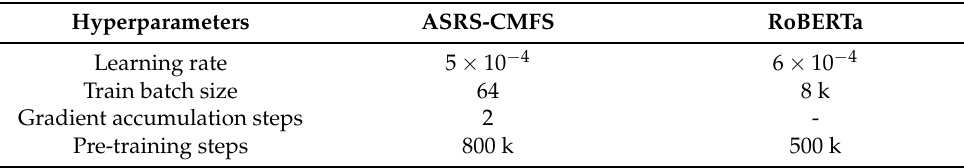
Table A1. Comparison of pre-training